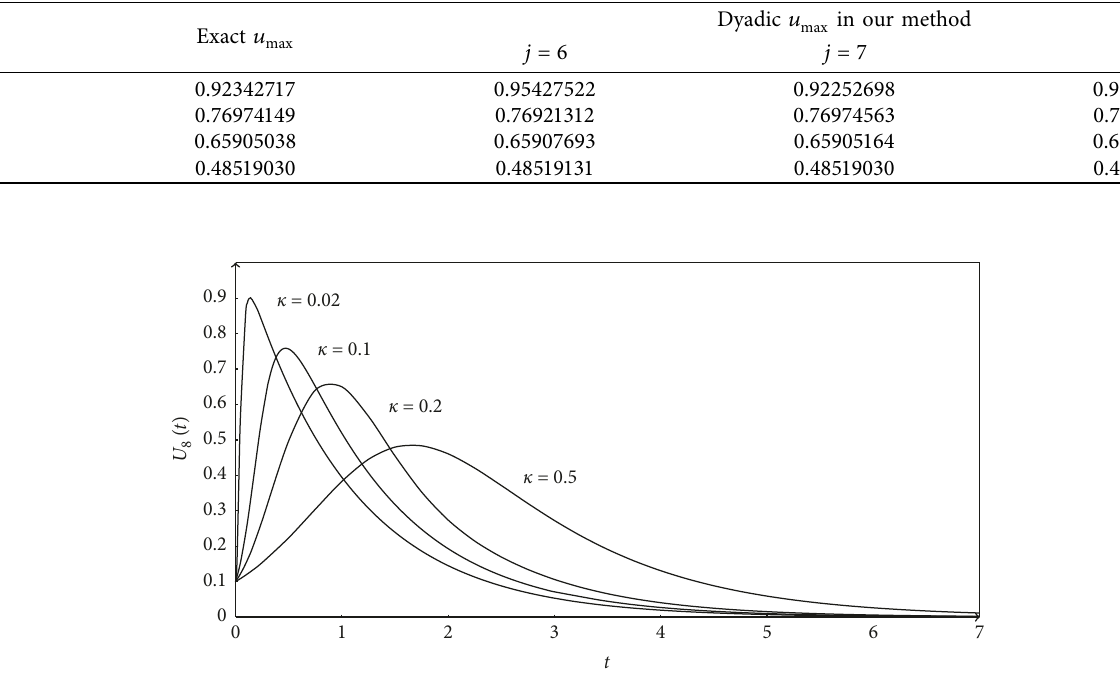
Figure 1: The result of Daubechies wavelet scaling functions for κ � 0 . 02 , 0 . 1 , 0 . 2 , 0 . 5.